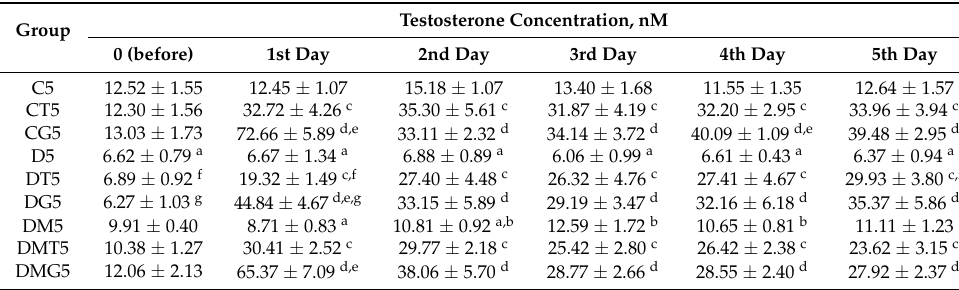
Table 3. The effects of five-week metformin treatment and five-day administration of TP3 and hCG on the blood testosterone levels in the control and diabetic animals.